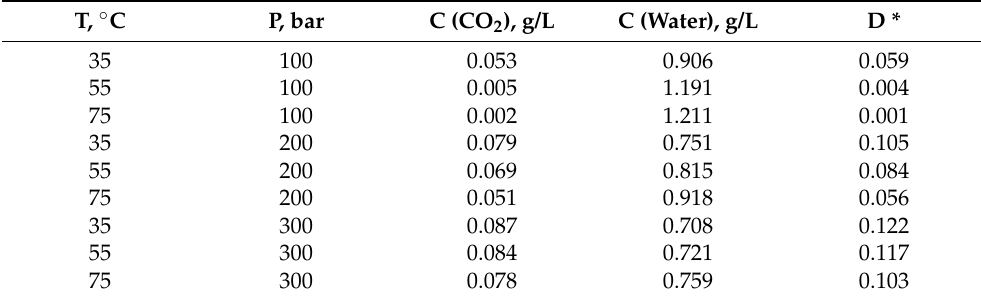
Table 3. Distribution of benzoic acid in a two-phase water–PEG–SC-CO 2 system at different pressure and temperature values. Initial concentration of benzoic acid in water–PEG solution is 1.221 g/L. T, ◦ C P, bar C (CO 2 ),